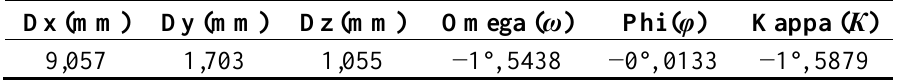
Table 1. Parameters transformation used to align reference systems (Proliner to